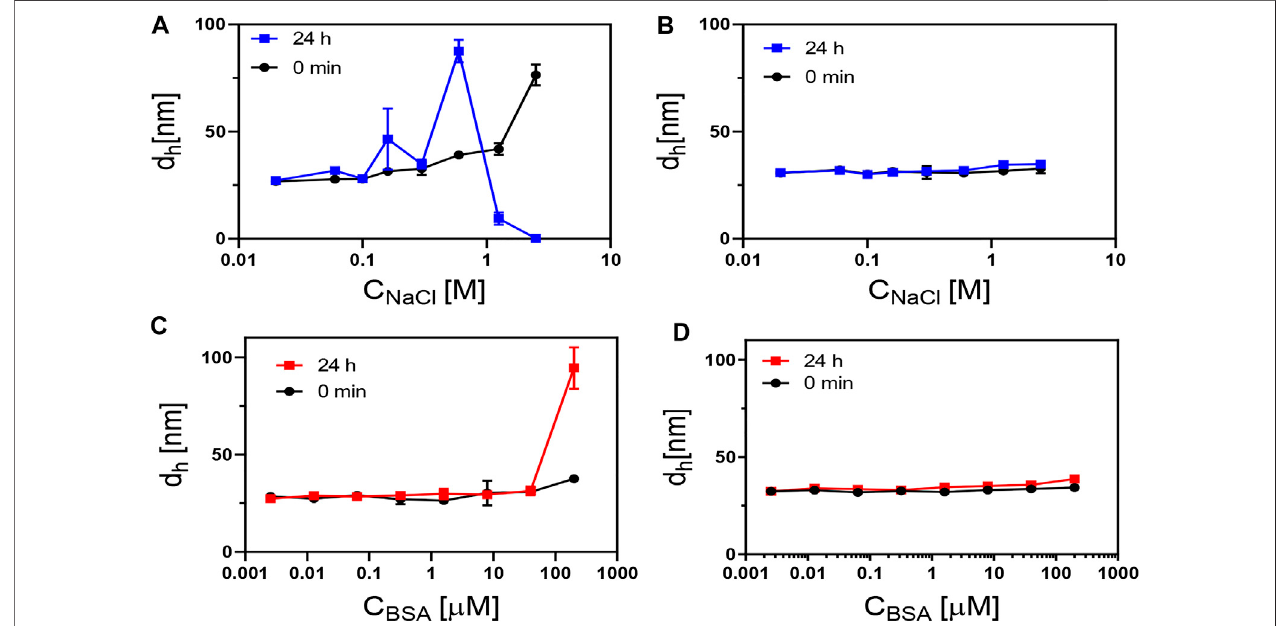
FIGURE 6 | Hydrodynamic diameter (d h ; here, the number distribution d h,N is plotted) of 18 nm IONPs coated with (A , C) PMA – DDA and (B , D) with dopamine – PMA – PEG, as measured at different concentrations of NaCl and BSA at 0 and 24 h after exposure. In (A) , the decrease in d h at high NaCl concentrations at 24 h is due to sedimentation of the NPs, which, in this way, are no longer in the light path of the DLS measurement.